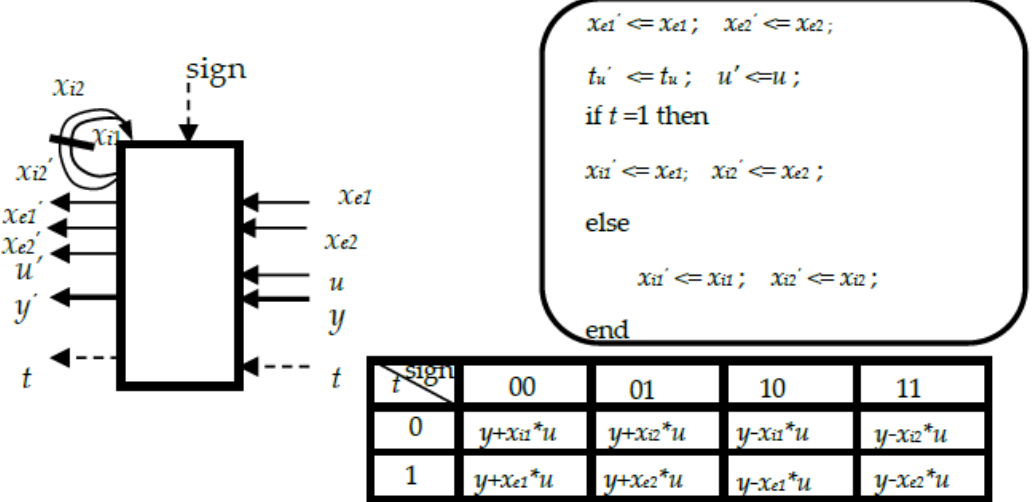
Figure 12. The function of the processing elements PE from Figures 13–16.